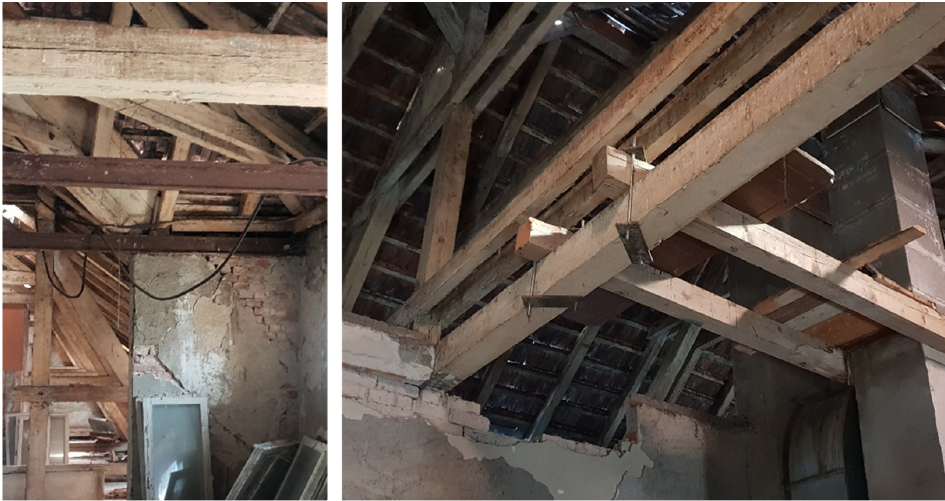
Figure 20. Overview of damage element after earthquakes impact—damaged of masonry walls in the function of roof structure supports.